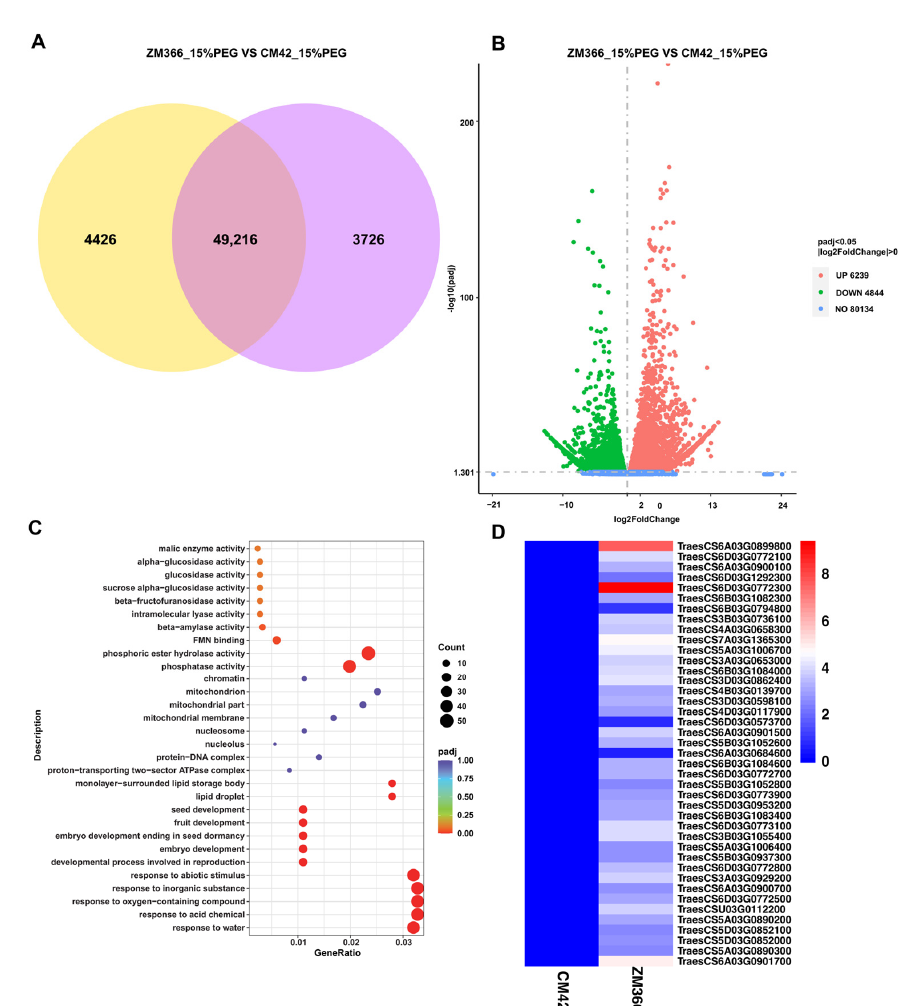
Figure 5. Transcriptomic analysis of ZM366 and CM42 treated with 15% PEG-6000. ( A ) Venn diagram of expressed genes in ZM366 and CM42 under 15% PEG-6000 treatment conditions. The yellow represents the genes expressed in ZM366. The purple represents the genes expressed in CM42. ( B ) Volcano map of differentially expressed genes (DEGs) in ZM366 and CM42 under 15% PEG-6000 treatment conditions. Up, 6239; down, 4844. ( C ) GO enrichment analysis bubble diagrams. The abscissa represents the ratio of the number of DEGs annotated with a GO term to the total number of DEGs, and the ordinate is the GO term; the size of the point represents the number of genes annotated with a GO term, and the color change from red to purple represents the significance of the enrichment. ( D ) Expression heatmap of the GO enrichment DEGs between CM42 and ZM366 under 15% PEG-6000 treatment conditions.